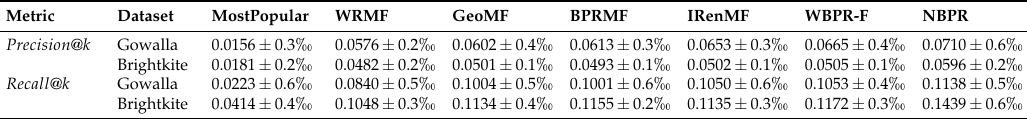
Table 3. Comparison results of our method with other related recommendation methods under the